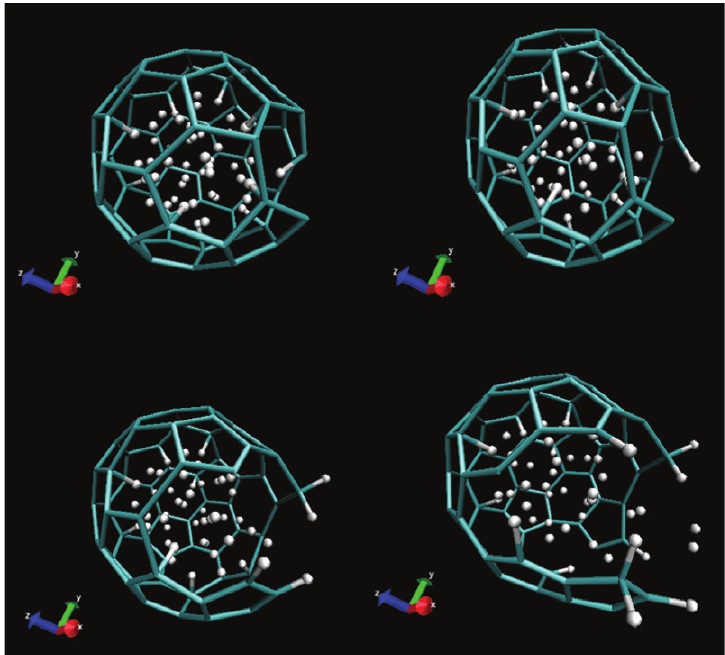
Figure 3 Snapshots of material failure for C60@H50 at 300